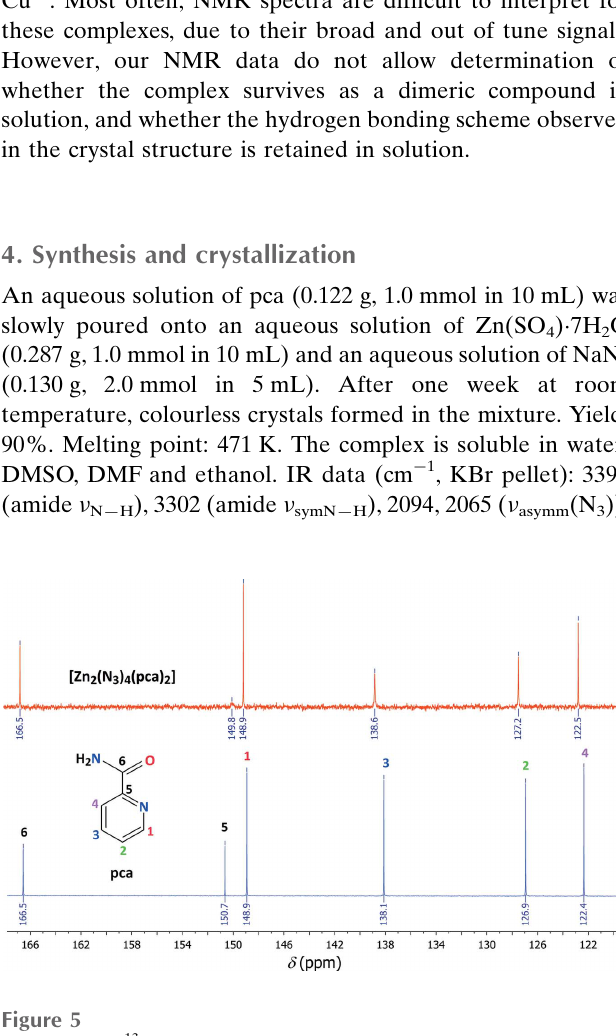
Figure 5 Experimental 13 C-NMR spectra of pca (blue) and [Zn 2 (N 3 ) 4 (pca) 2 ] (red) in DMSO- d 6 . Chemical shifts are given in Table 3.